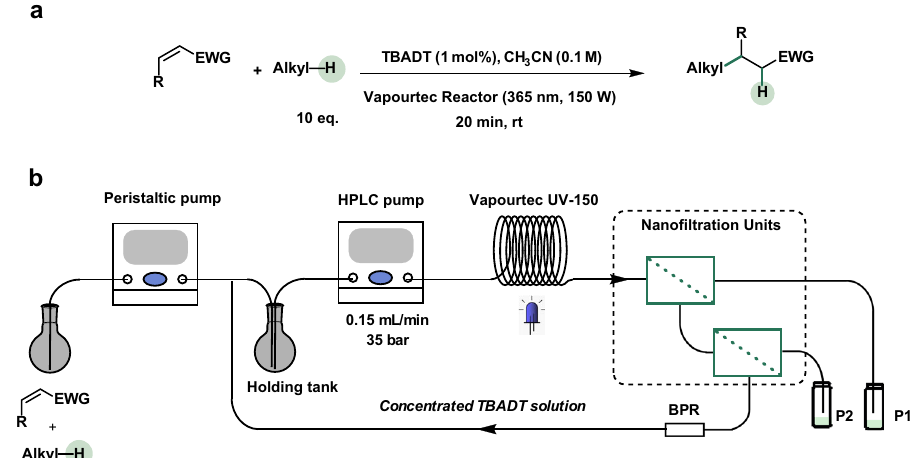
Fig. 2 | C(sp 3 ) – H alkylation with in-line TBADT recovery via nano fi ltration. a TBADT-catalyzed C(sp 3 ) – H alkylation investigated in the present work. b fl ow chart of the multi-stage nano fi ltration-based continuous- fl ow system employed